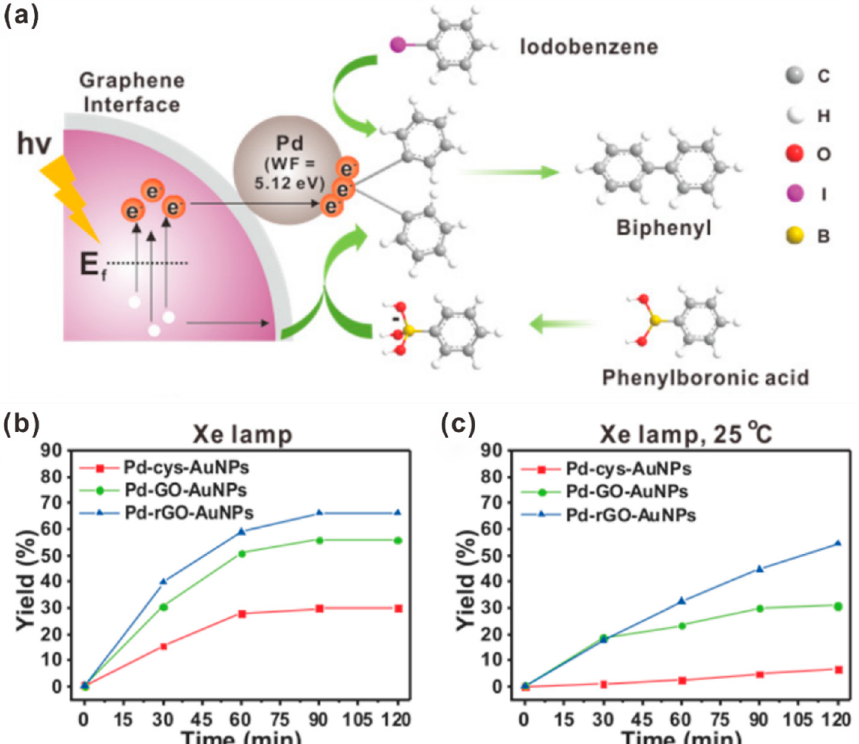
Figure 11. Pd-nanodot-decorated AuNPs with a graphene interface for visible-light-induced photo- catalytic Suzuki–Miyaura coupling reaction. ( a ) The scheme of the Suzuki–Miyaura cross-coupling with Pd nanodot-decorated AuNPs and ( b , c ) the catalytic activities of Pd-cys-AuNPs, Pd-GO-AuNPs, and Pd-rGO-AuNPs for the reaction under various conditions. Reproduced with permission from Reference [119]. Copyright 2018 Creative Commons Attribution.